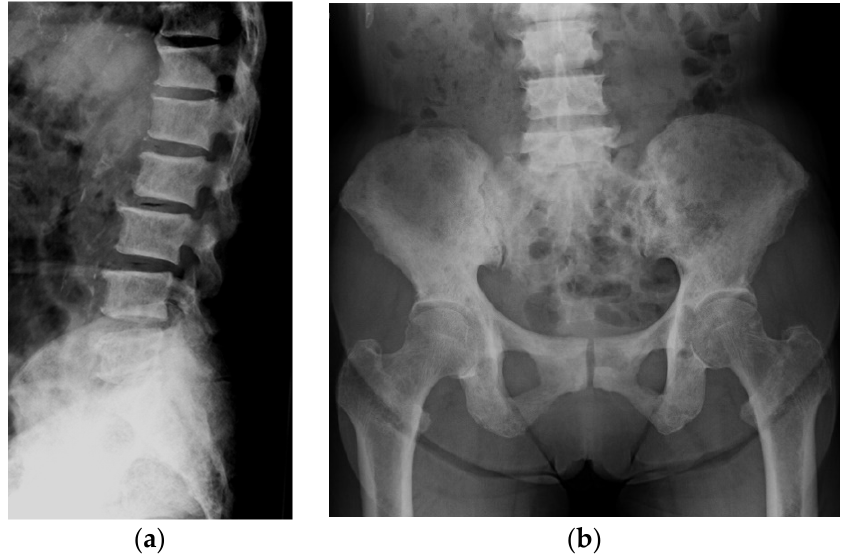
Figure 1. ( a ) Plain radiograph obtained before treatment showing sclerotic changes in the thoracic and the lumbar spine (lateral view). ( b ) The sclerotic changes extended to the pelvis but with no involvement of the femur (anteroposterior view).